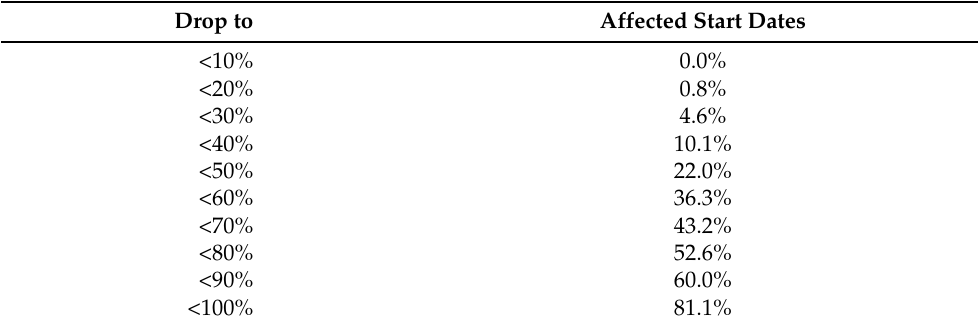
Table 4. Affected starting dates after which the Bitcoin price drops below a certain percentage of the given day’s price between January 2017 and April